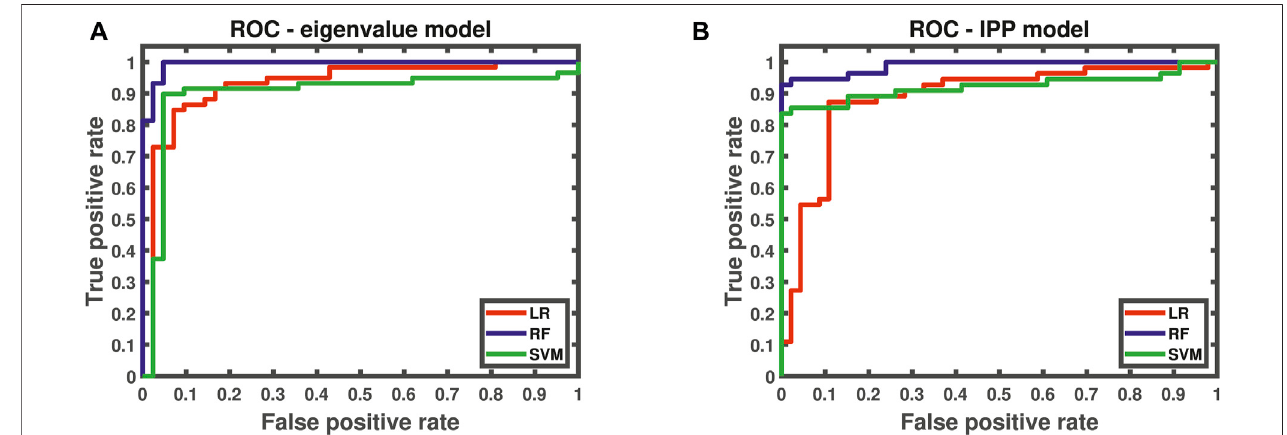
FIGURE 5 | ROC curves for (A) eigenvalue model (trained with 7 PCs and their scores) and (B) IPP model (trained with 6 PCs and their scores).